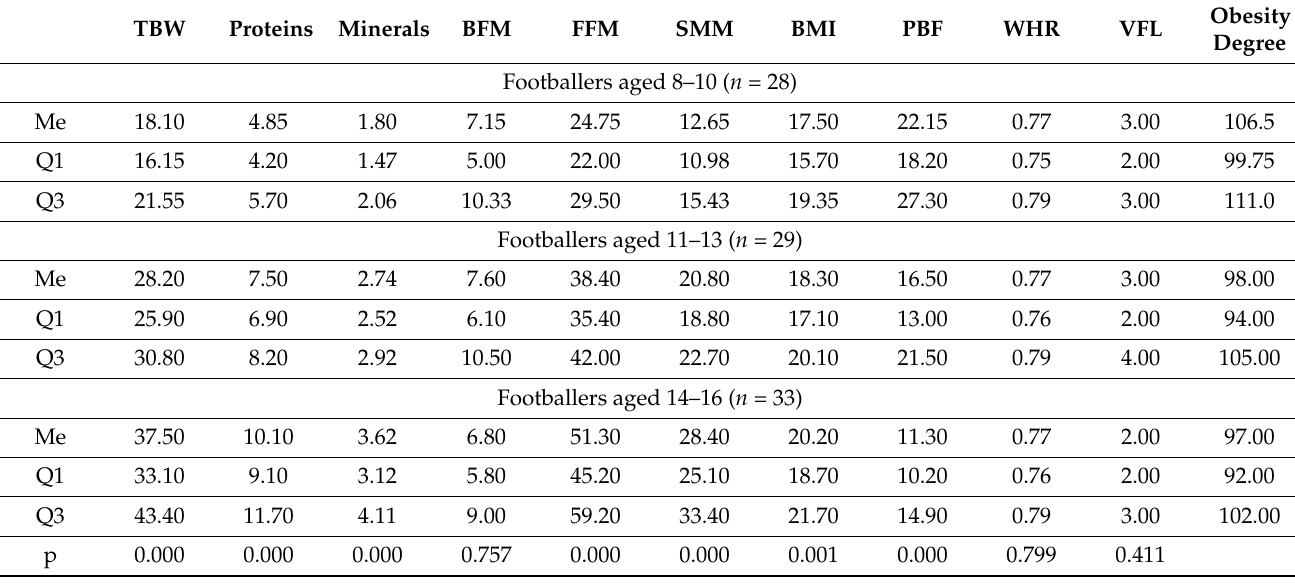
Table 6. Characteristics of selected body composition parameters (InBody) and the level of statistical significance of differences between the investigated footballers classified in age